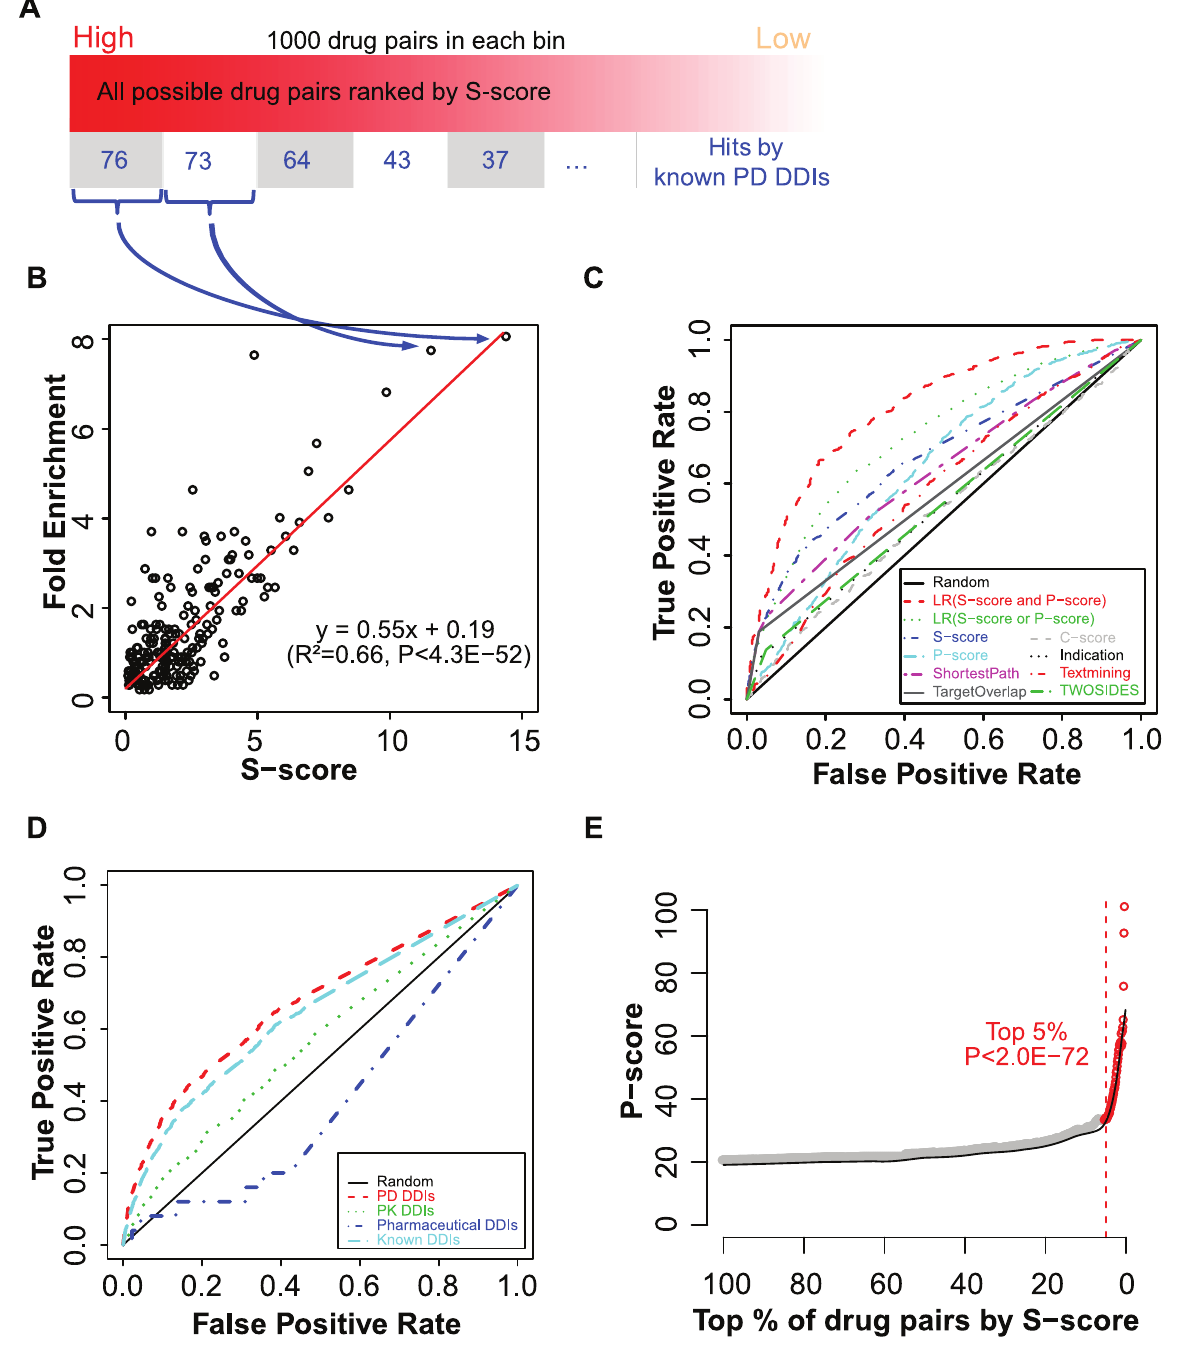
Figure 3. Performance evaluations. ( A ) All possible drug pairs ranked and binned into groups by their S-score. ( B ) Fold-enrichment of hits of known PD-like DDIs in each bin ( y -axis) plotted against average S-score ( x -axis). ( C ) ROC curves to evaluate the performance of various scoring methods using DrugBank PD-like DDIs as GSPs. ( D ) ROC curves to evaluate the prediction performance of S-score using three types (PD, PK, pharmaceutical) or known DDIs in DrugBank as GSPs. ( E ) Associations of S-score with drug clinical side effect similarity (P-score). Average of P-score (y-axis) is plotted for top N% of drug pairs ranked by S-score (x-axis). P-value for top 5% drug pairs against all possible drug pairs was calculated from Wilcoxon rank sum test.